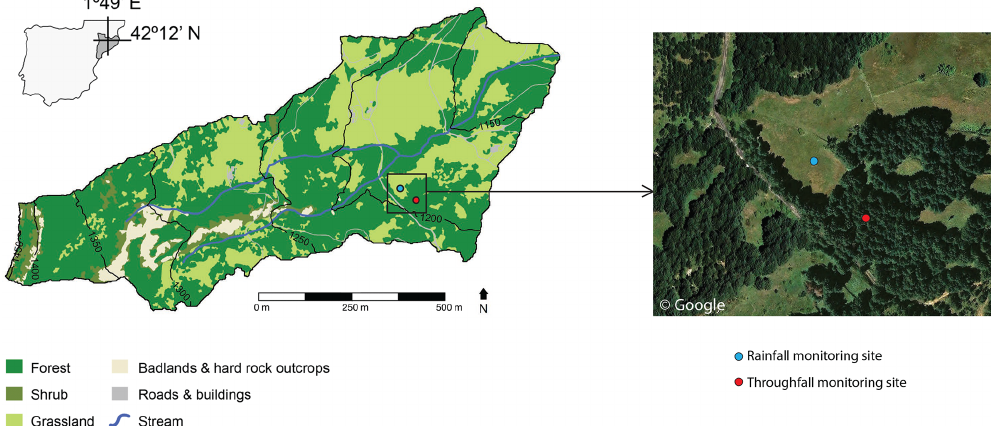
Figure 1. Location of the monitoring sites within the Can Vila catchment, Spain.